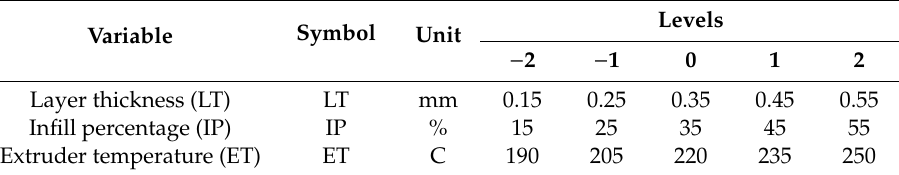
Table 1. Levels of independent variables.